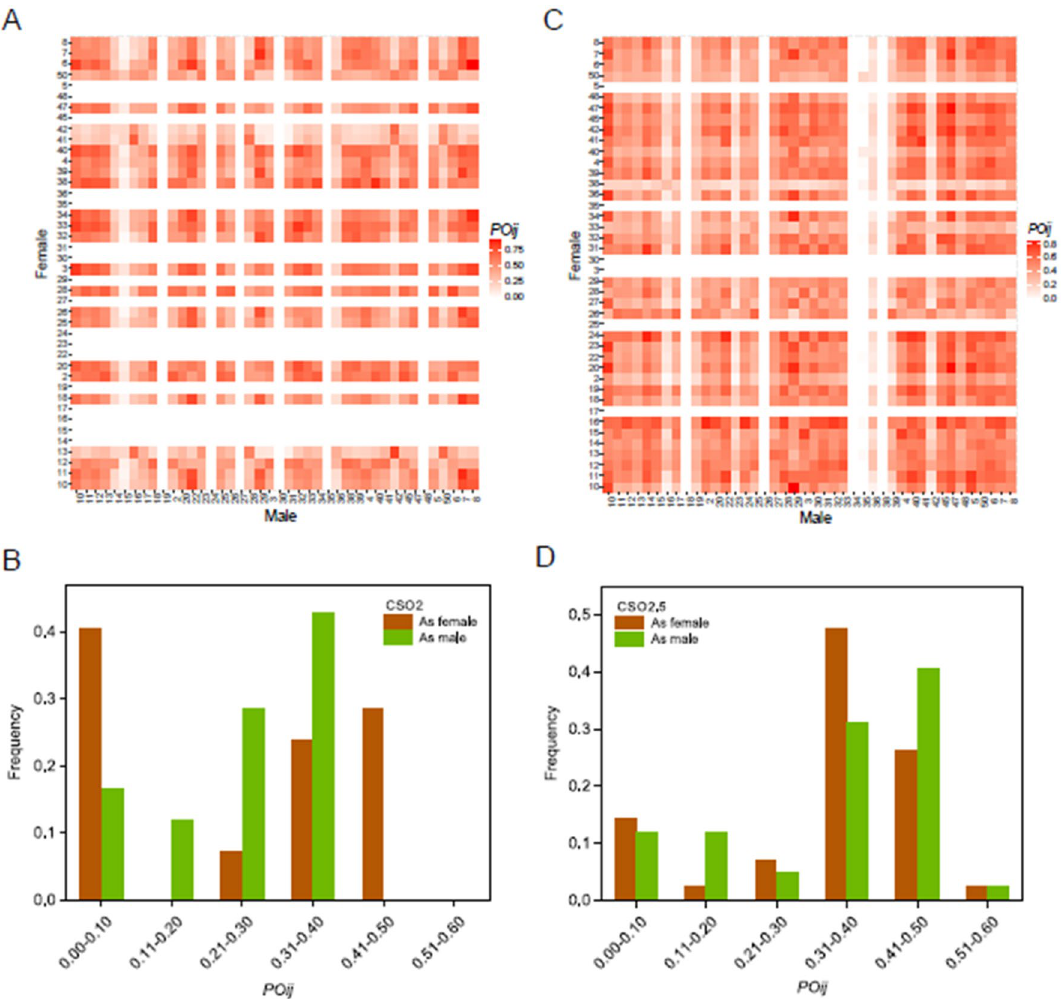
Figure 4. Phenological synchronicity ( POij ) and its distribution of clones for female and male flowering in CSO2 ( A , B ) and CSO2.5 ( C , D ). The clones listed in ( A ) and ( C ) are ordered by the number of clones.